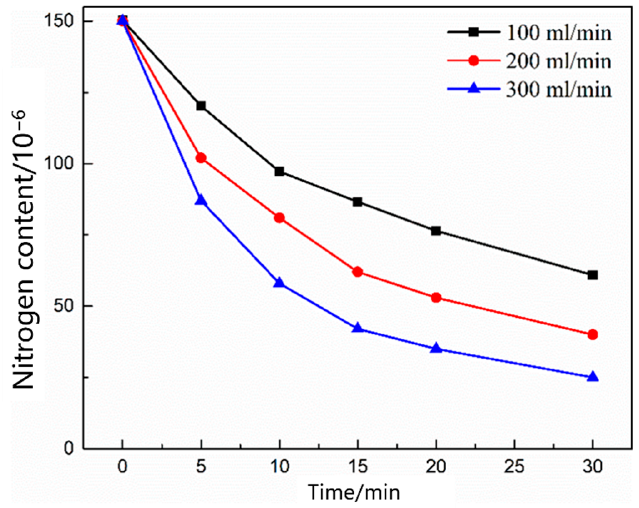
Figure 12. Change in the nitrogen content in the liquid steel under different flow rates.